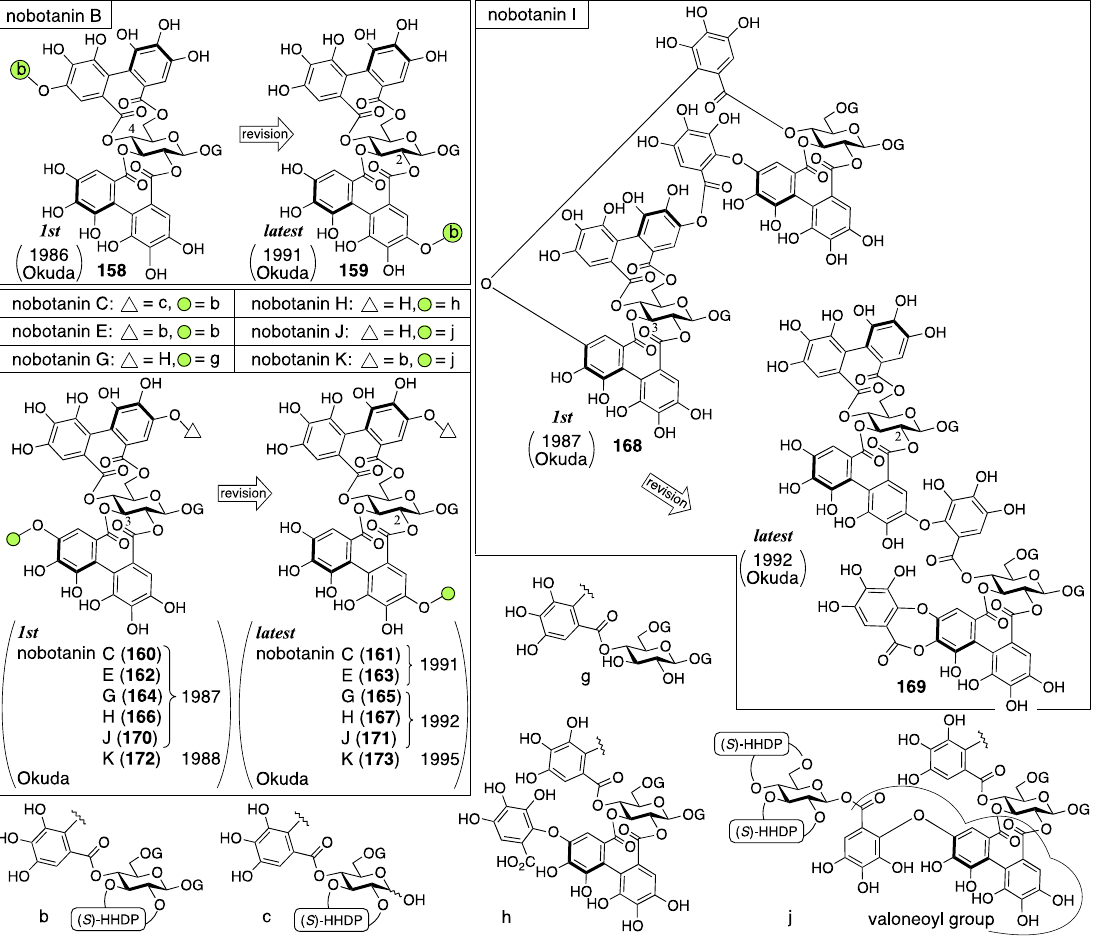
Figure 54. The information that led to the first structure of nobotanin B ( 158 ).